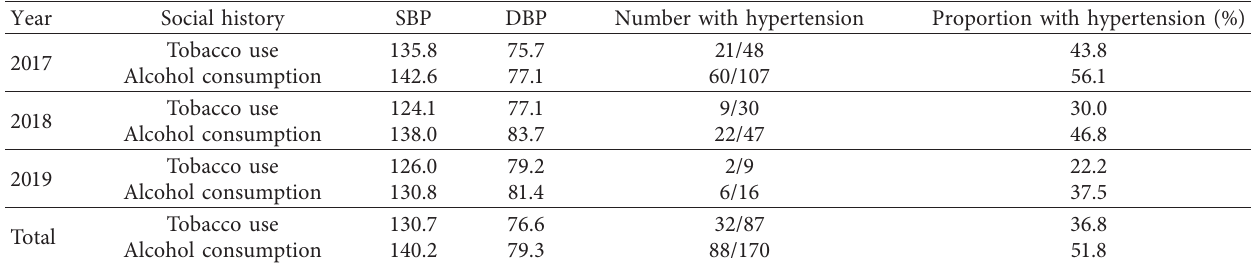
Table 4: Mean BP of participants according to social